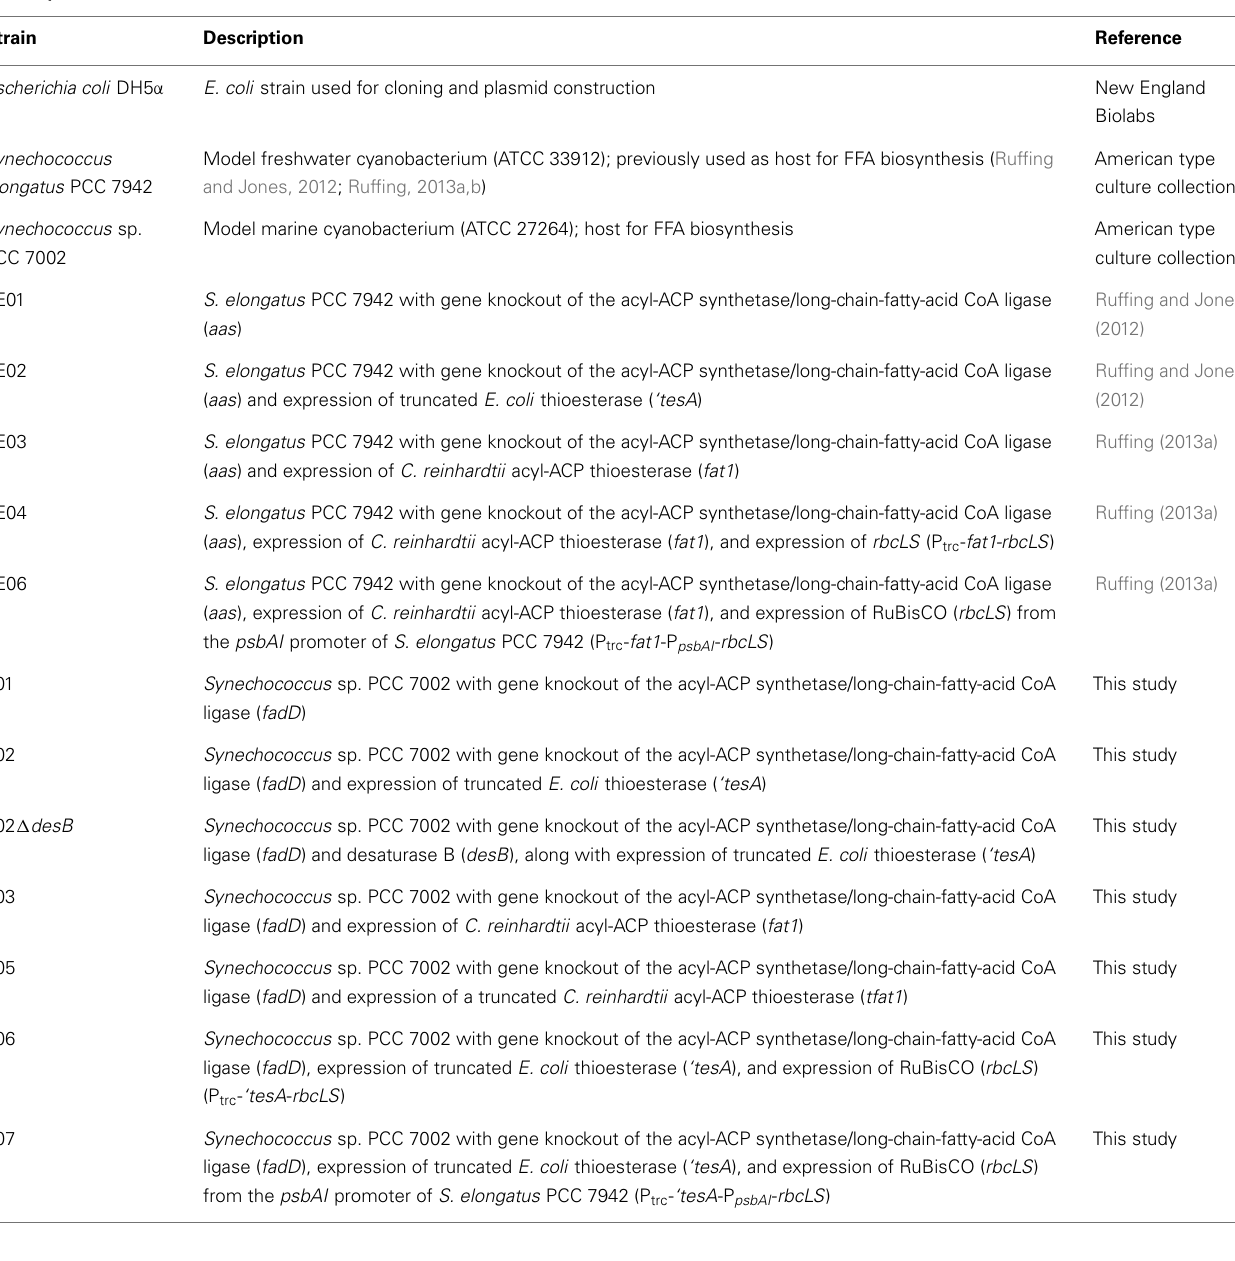
Table 1 | Strains used and constructed in this study